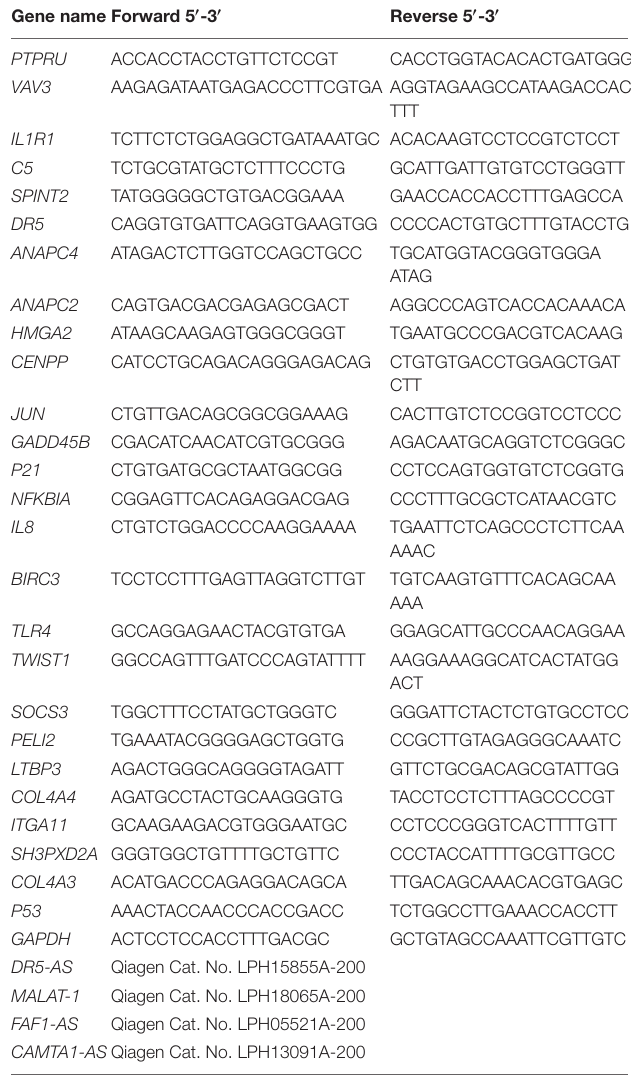
TABLE 1 | Primer sequences employed throughout the